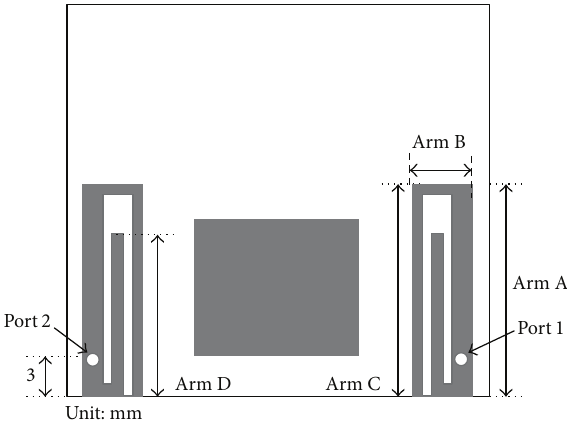
Figure 2: Detailed front view of structure of proposed